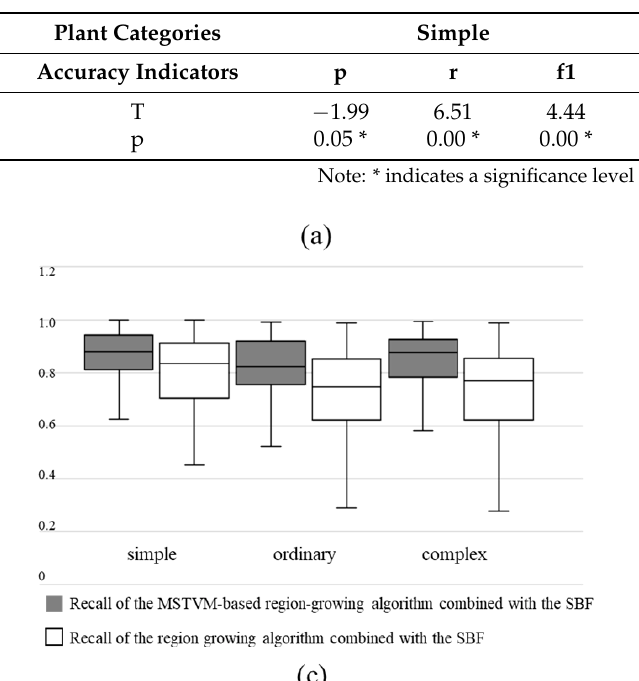
Table 6. The t -test of precision, recall, and F1-Score values of segmented leaves for the whole plant by the MSTVM-based region-growing algorithm combined with SBF and by the region-growing algorithm combined with SBF.